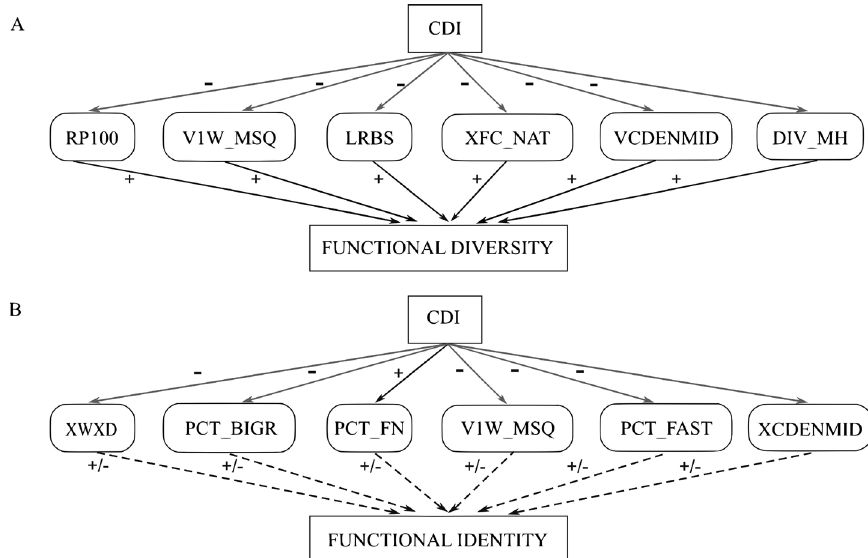
FIGURE 3 | Predictions tested using structural equation modeling, indicating the expected pathways (arrows) for the effects of catchment degradation (CDI) on stream physical habitat and, consequently, on the functional structure of the fish assemblages. Land use is expected to influence the functional diversity mediated by alterations in habitat heterogeneity and stability ( A ), and to influence functional identity, mediated by changes in habitat type ( B ). Arrows indicate expected effects between predictive and response variables, which can be positive (black continuous line), negative (gray continuous line) or non-directional (dashed lines). For physical-habitat codes, calculation and ecological meaning, see Tab.